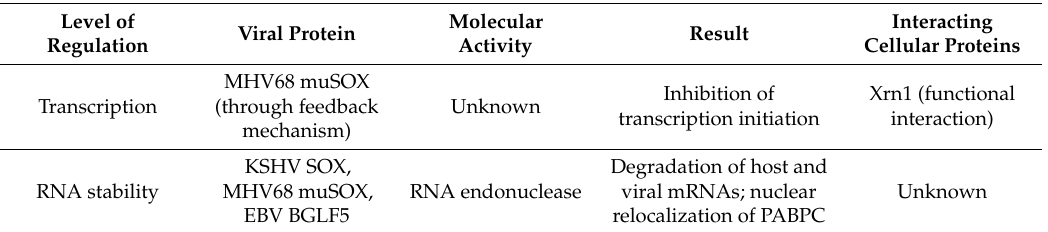
Table 2. Host shutoff mechanisms in γ